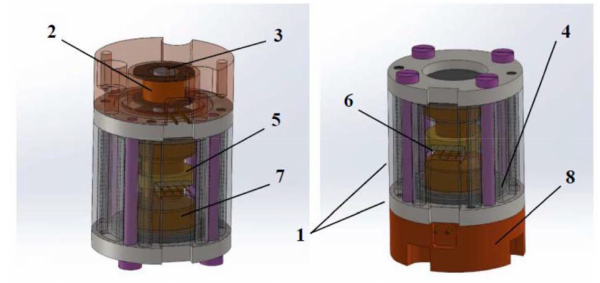
Figure 3. Constructional parts of the MET hydrophone. 1 – external body; 2 – coil; 3 – magnet; 4 – membranes; 5 – electrical package; 6 – electrical terminals of anodes and cathodes; 7 – electrolyte; 8 – cover with air bubble under